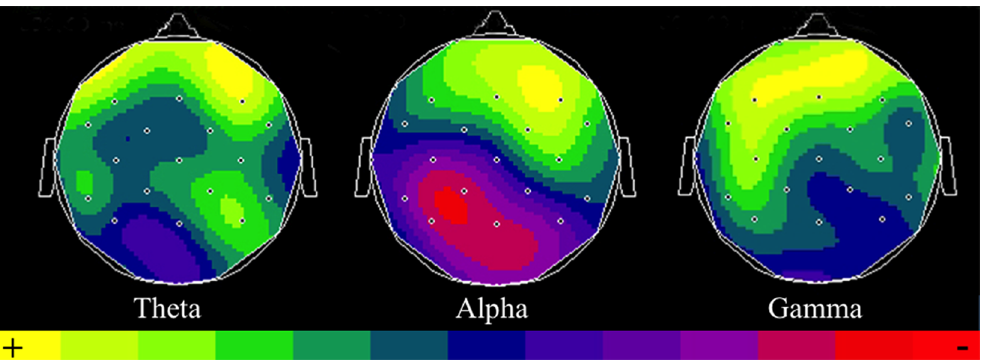
Figure 4. Scalp distribution of the different frequency bands at the significant time-windows. From the left: scalp distribution of theta waves (Z value for the contrast Ironic / Literal ); scalp distribution of alpha waves (Z value for the contrast Ironic / Literal ) and scalp distribution of gamma waves (Z value for the contrast Ironic / Literal ).